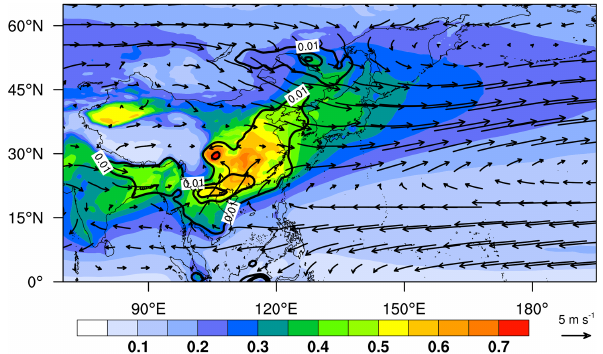
Figure 1. Spatial distribution of climatological spring (MAM) mean aerosol optical depth (AOD; shading) and 850hPa wind (vector; ms − 1 ). Black contours denote spring AOD’s variance with interval of